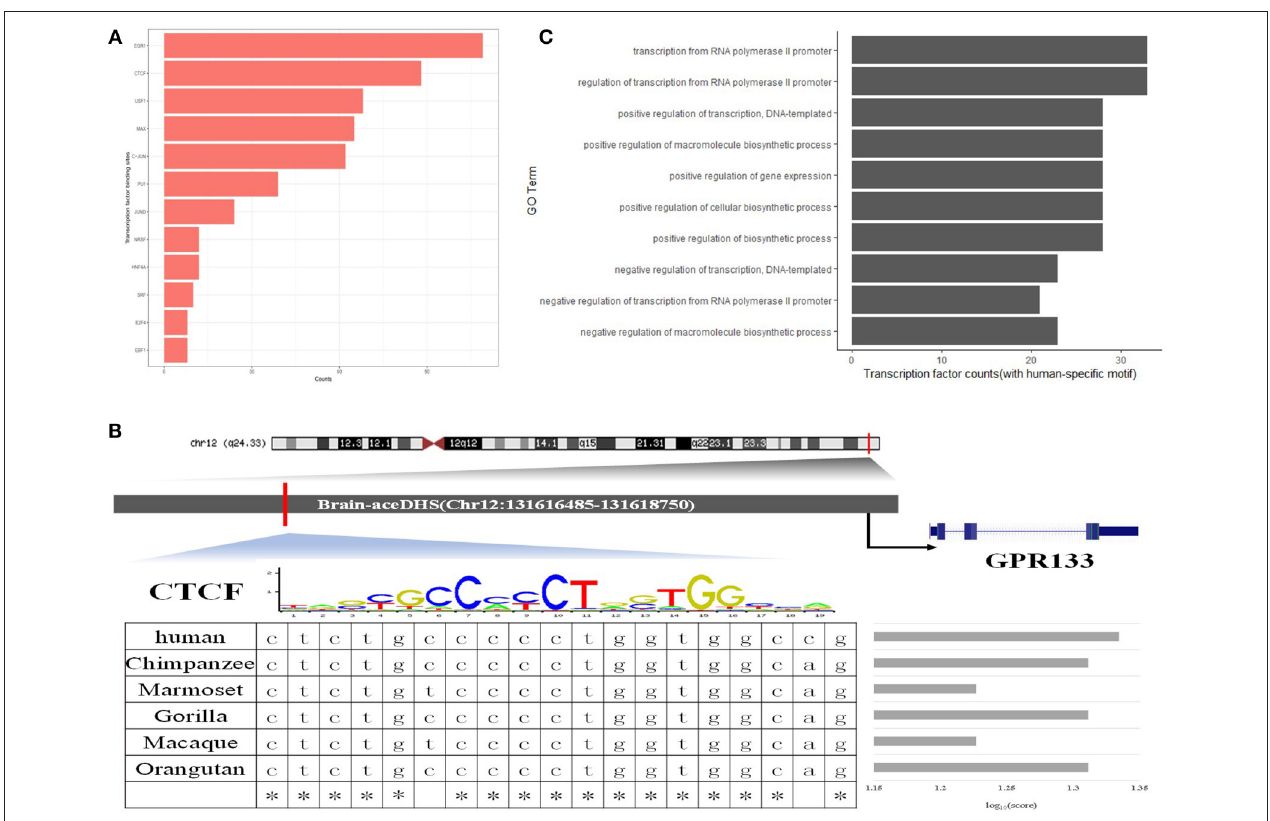
FIGURE 3 | (A) Top 10 transcription factor binding sites in brain-aceDHSs, according to the UCSC database. (B) Examples of human-specific transcription factor binding sites. (C) GO enrichment analysis of human-specific transcription factor binding sites.